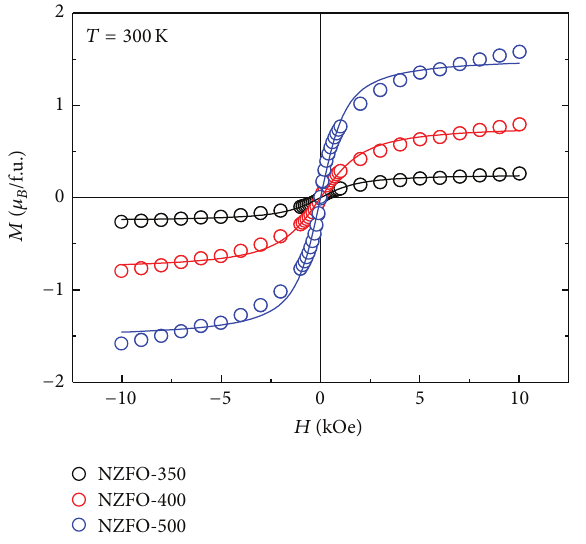
Figure 6: The M-H loops for Ni-Zn ferrites with different particle sizes at